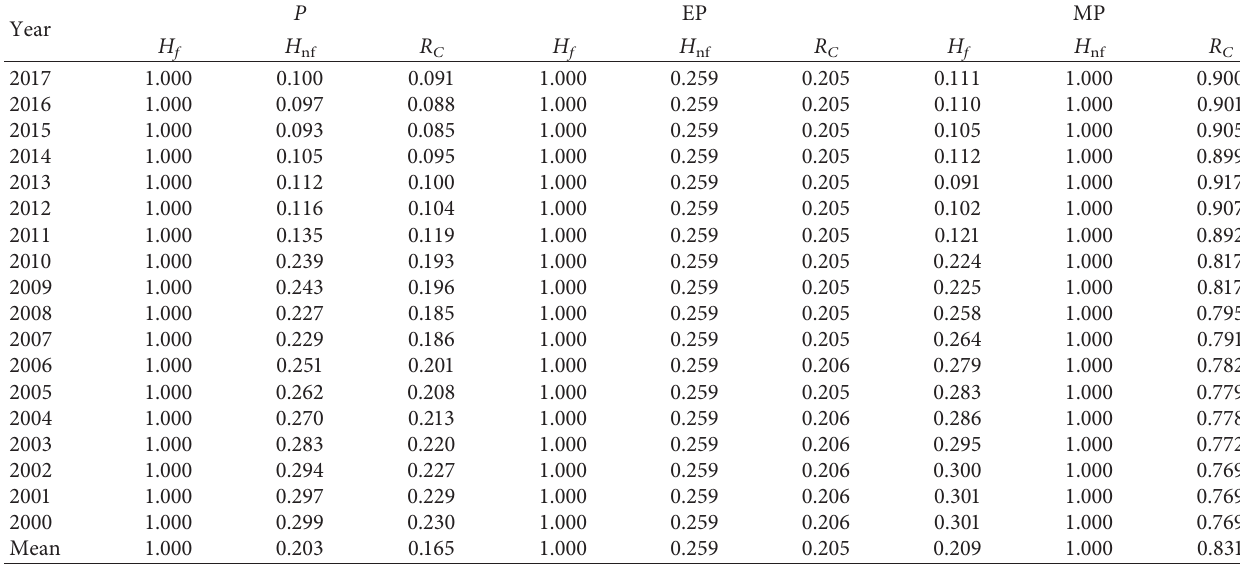
Table 3: H f ( π ), H nf ( π ), and R C of P , EP, and